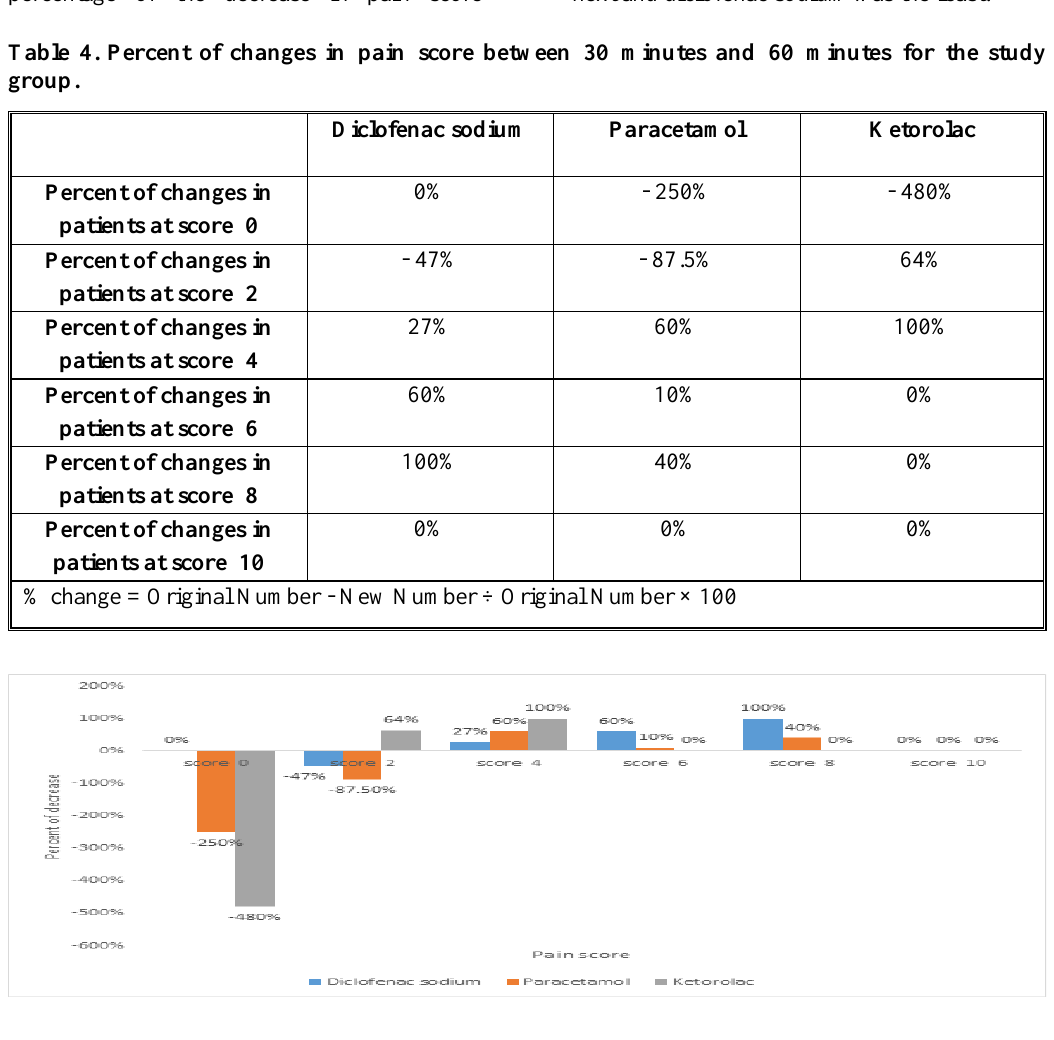
Figure 3. Percent of changes in pain score between 30 minutes and 60 minutes of surgery for the study